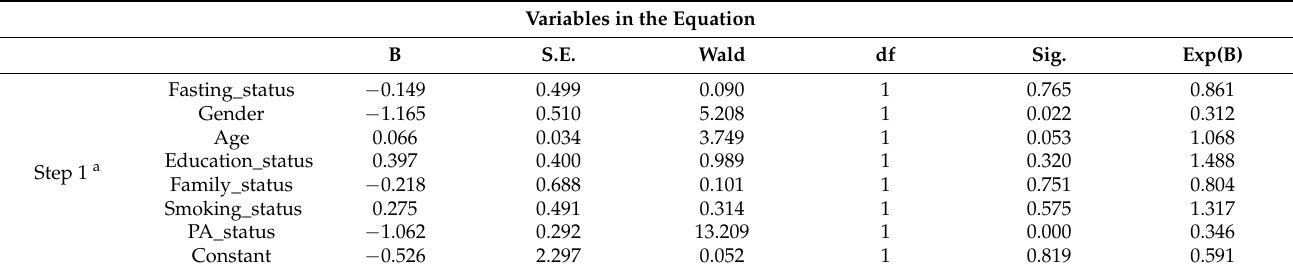
Table 4. Logistic regression analysis results.